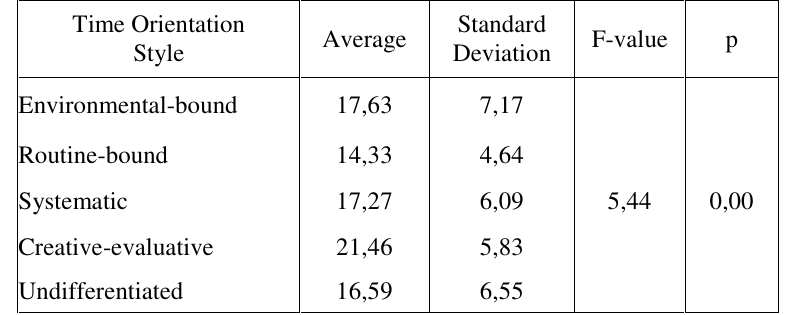
ANALYSIS OF VARIANCE FOR TIME ORIENTATION STYLE AND